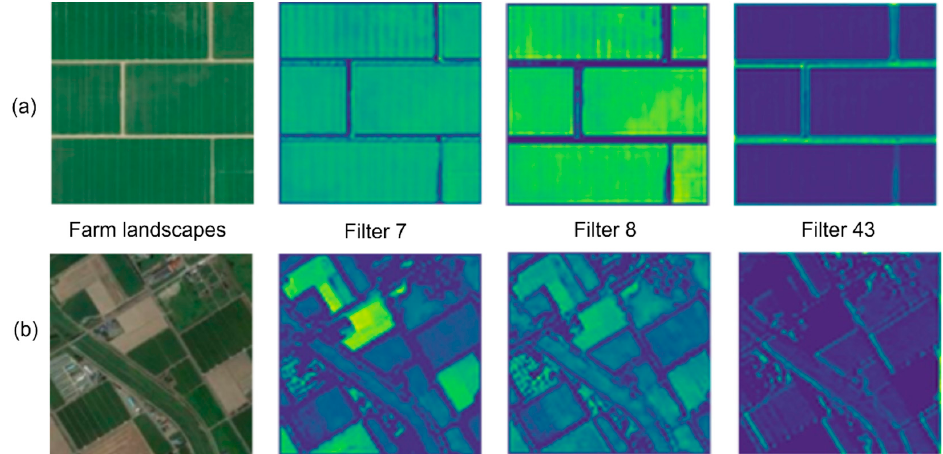
Figure 11. Farm landscapes and feature maps. Row ( a ) Sentinel dataset and row ( b ) AID dataset samples. Feature maps are extracted from Filters 7, 8, and 43. It can be seen that certain filters (e.g., Filter 43) specialize in detecting farm boundaries, while Filters 7 and 8 detect regions with vegetation.